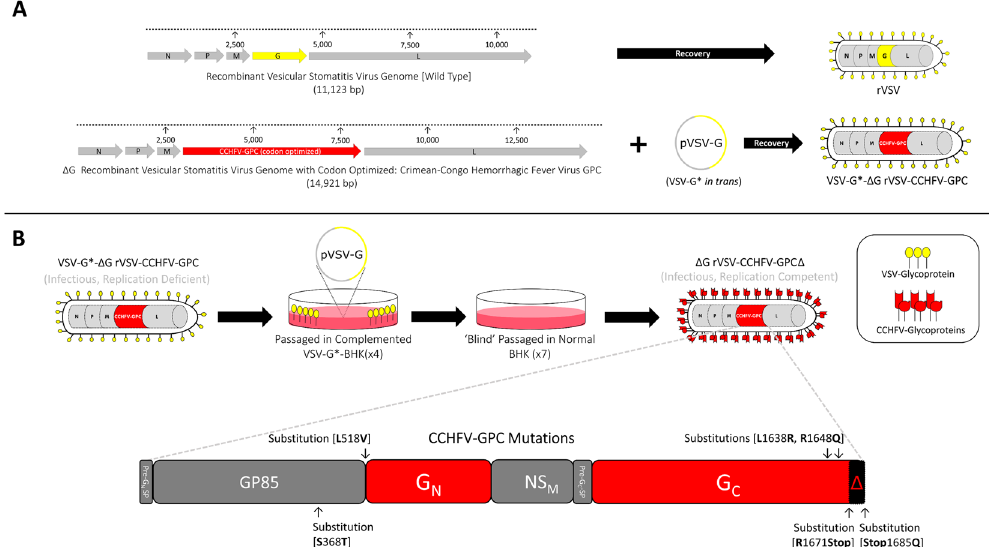
Figure 1. rVSV vector designs and vaccine study strategy. ( A ) Generating a replication deficient vaccine vector: Genome organization comparing VSV (wild-type) genome (in grey arrows) and the rVSV vector expressing the CCHFV-GPC codon optimized open reading frame. N; nucleoprotein, P; phosphoprotein, M; matrix protein, and L; large polymerase protein. The rVSV vector had the VSV glycoprotein open reading frame (yellow arrow) exchanged with the open reading frame coding for the full glycoprotein precursor gene (GPC) of CCHFV (red arrow). Using a T7 driven DNA clone recovery system, a complemented VSV-G * recombinant was generated containing the CCHFV-GPC open reading frame (VSV-G * - Δ GrVSV-CCHFV- GPC). ( B ) Generating a replication competent vaccine vector: VSV-G * - Δ GrVSV-CCHFV-GPC is